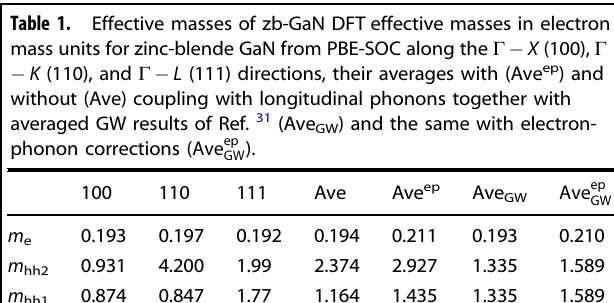
Table 2. Band energy shifts in zb-GaN Energy shifts in zinc-blende GaN due to electron-phonon interaction for the VBM ( Δ E ep Γ ; ) and for the edge of the light hole band ( Δ E ep Γ ; CBM ( Δ E ep Γ ; c with variations of the quasi-particle band gap ( Δ E ep masses (This) or GW ones from Ref. 31 (This GW ) have been